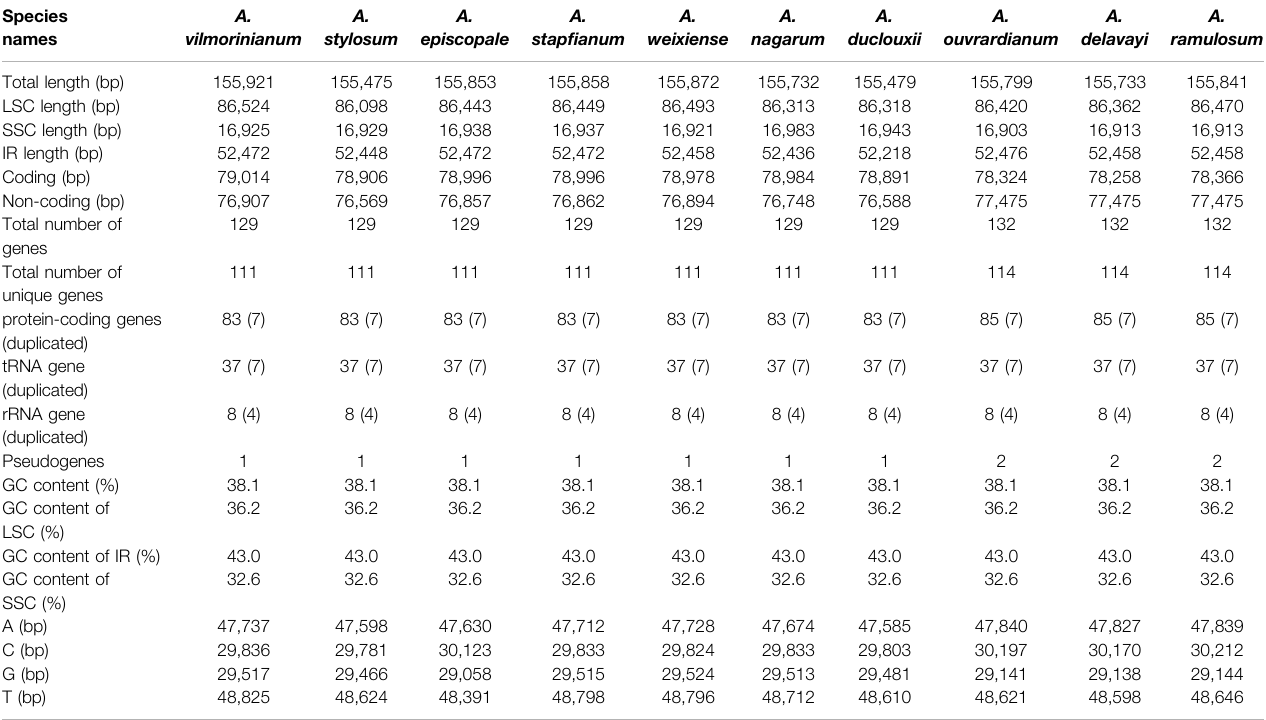
TABLE 2 | Basic characteristics of complete chloroplast genomes in ten Aconitum